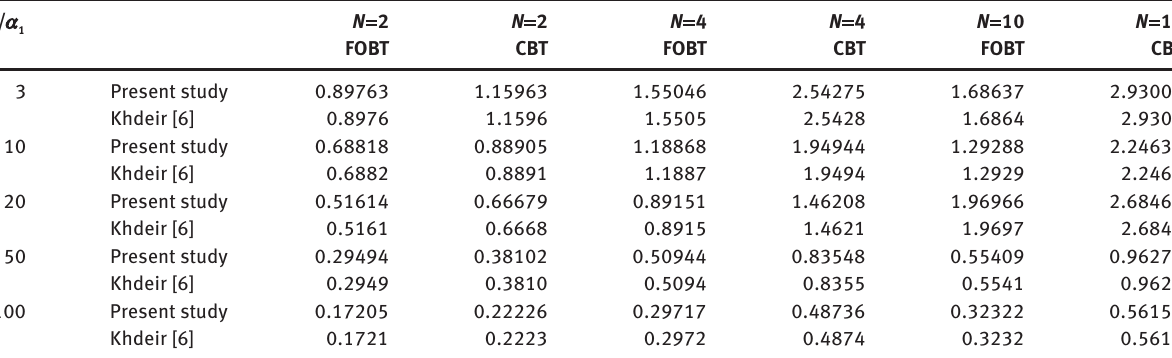
between the results of this study and those reported by Khdeir [6] for a composite laminated beam with the anti- Table 4 Comparison of λ cr symmetric cross-ply [0/90] lamination scheme, L / h = 10, C-C edge supports and α N /2